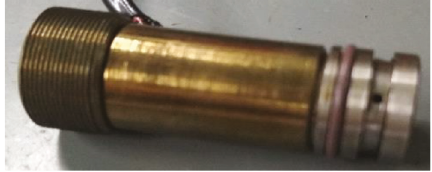
Figure 4: Miniature high-speed digital